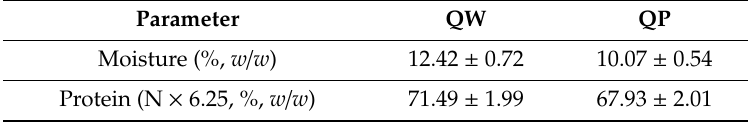
Table 1. Moisture and protein content of protein isolates of two quinoa varieties.